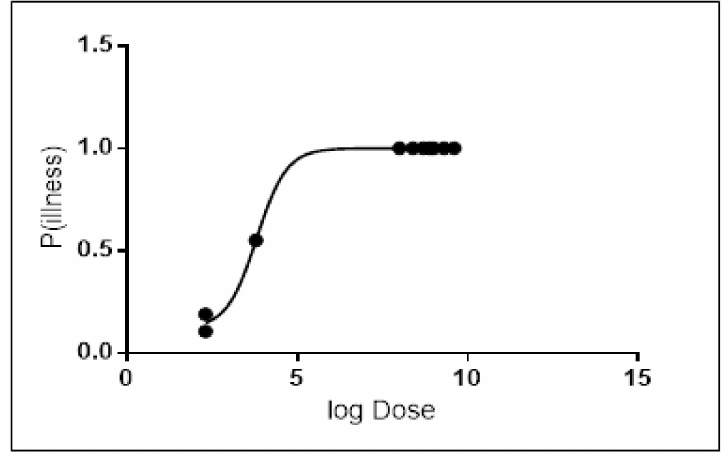
Figure 4. Dose–response graph for Salmonella enterica serovar